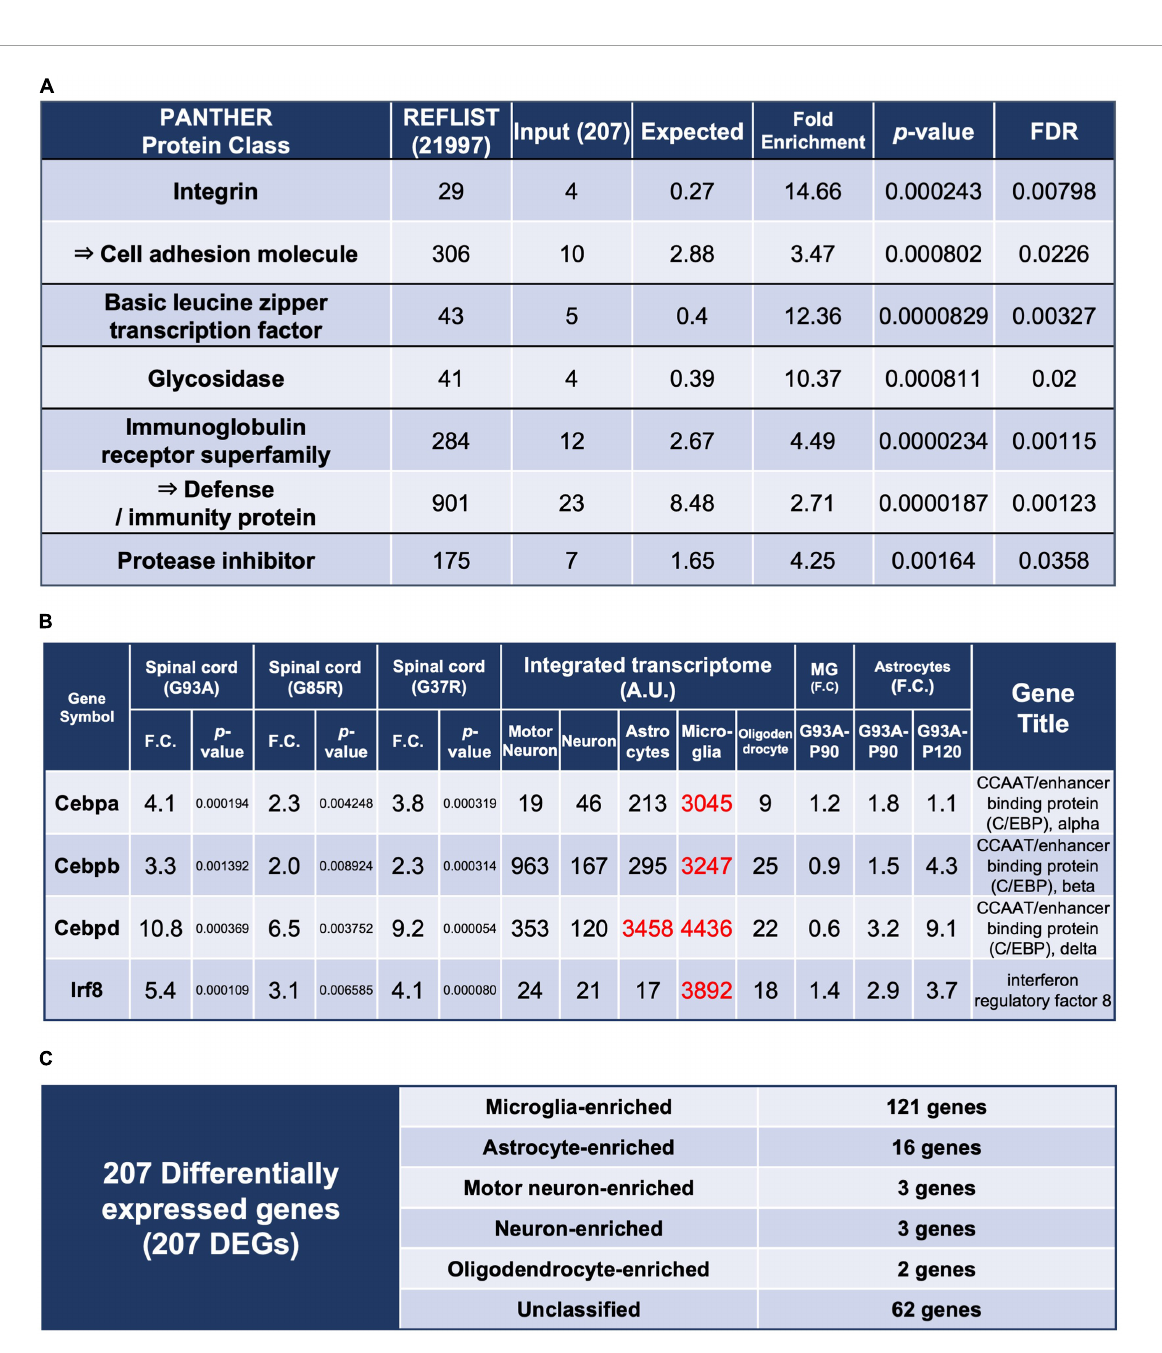
FIGURE2 Enrichment analysis using the 207 DEGs and classification of each of the 207 DEGs by cell types with high expression. (A) Enrichment analysis using the 207 DEGs as an input. The first column shows the name of the PANTHER classification category. The second column shows the number of genes in the reference list that map to this particular PANTHER classification category. The total number of genes in the reference list is 21,997. The third column shows the observed number of genes in our input list that map to this PANTHER classification category. The fourth column shows the expected value, which is the number of genes we would expect in our list for this PANTHER category, based on the reference list. The fifth column shows the fold enrichment, which is the ratio of the value of column 3 (input: observed number) over that of column 4 (expected number). The sixth column shows the raw p -values. The seventh column shows the q -value (adjusted p -value, reflecting the false discovery rate) as calculated by the Benjamini-Hochberg procedure. Cell adhesion molecule is in the parent category of integrin, so it is shown in the row below. Similarly, defense/immunity protein is the parent category of immunoglobulin receptor superfamily . Therefore, they are indicated with arrows. (B) Representative transcription factors in the 207 DEGs. Three CCAAT/enhancer binding proteins and interferon regulatory factor 8 are shown. (C) All of the 207 DEGs were classified into cell types in which each gene is highly expressed; Unclassified are the genes that are not highly expressed in one particular cell type. MG,